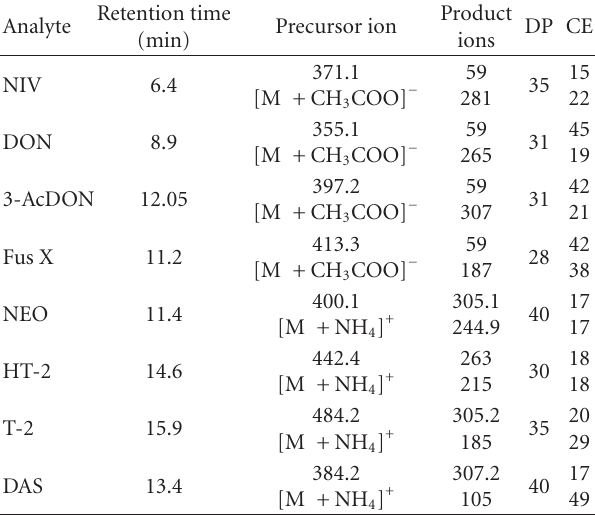
Table 1: LC/MS/MS characteristics of the analyzed compounds.